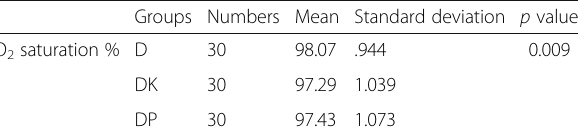
Table 3 Oxygen saturation Groups Numbers Mean Standard deviation p value